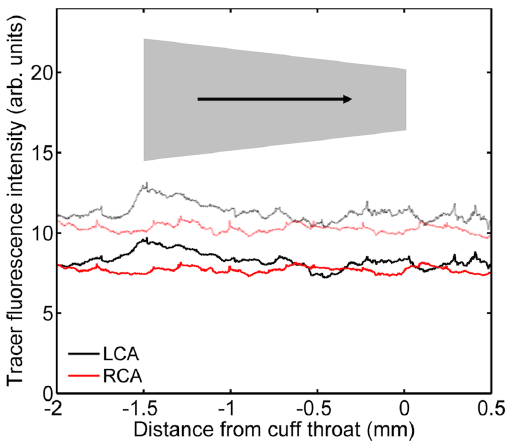
Fig. 14. Tracer uptake along vessels in mice administered tracer just before death. Fluorescence intensity along the length of carotid arteries of mice having the cuff placed in the conventional direction and administered tracer 1 minute rather than 10 minutes before sacrifice. Intensity is shown separately for the cuffed left carotid (‘‘LCA’’) and uncuffed right carotid (‘‘RCA’’). Flow direction, cuff location and cuff orientation are indicated as described for Fig. 2. Mean (dark lines) + 1 SEM (light lines), n 5